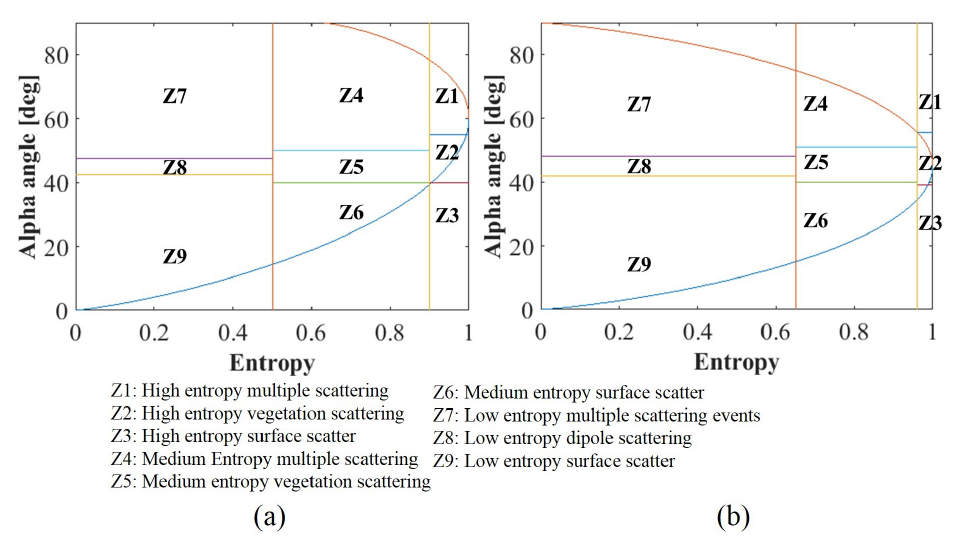
Figure 2. The H /¯ α plane. ( a ) FCP and FLP; ( b )